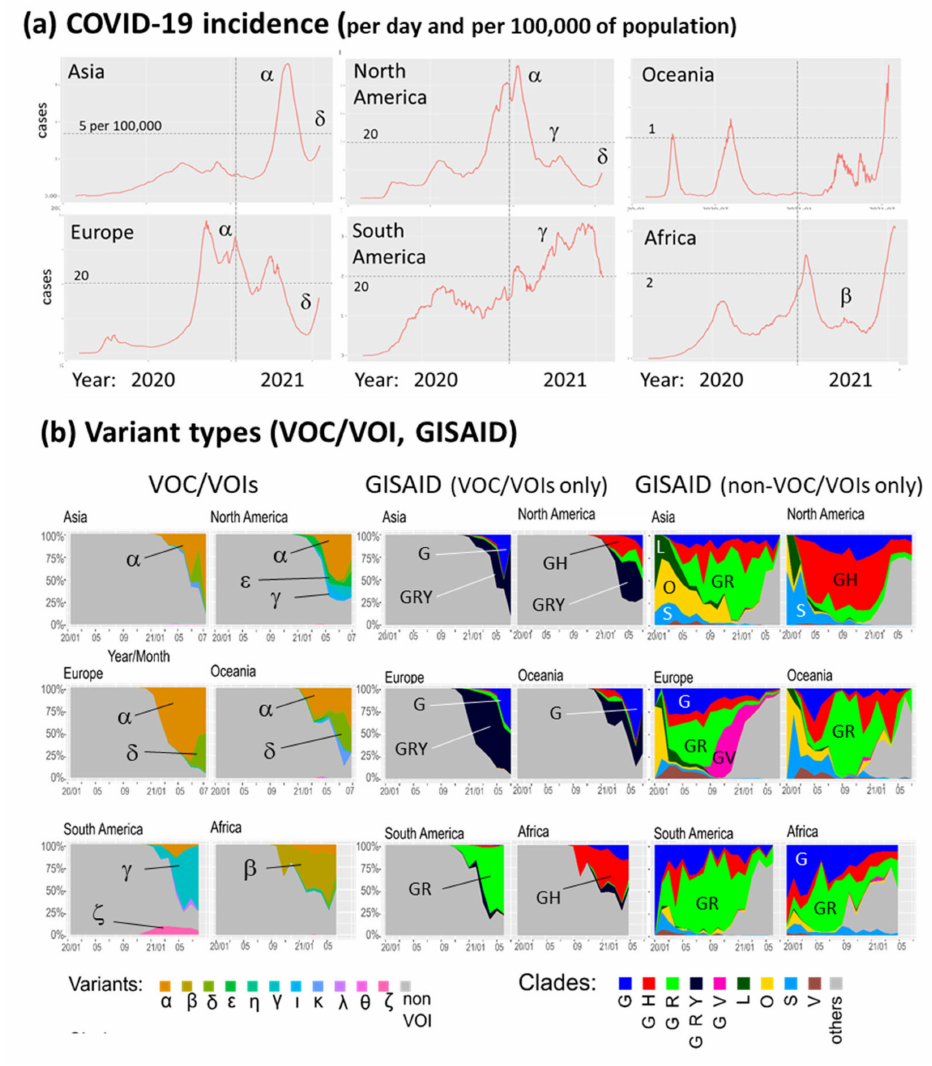
Figure 3. COVID-19 in time and space. ( a ) Incidence (in units of reported COVID-19 cases per day and per 100,000 of population) since January 2020 in different regions of the world. VOCs/VOIs (Greek letters) refer to the most abundant variants taken from part b. Plots were generated using the COVID-19 viewer (https://www.izbi.uni-leipzig.de/current-projects/covid19-viewer/, down- loaded at 17 July 2021) [28]. ( b ) Composition of COVID-19 cases regarding VOC/VOIs (left part) and GISAID (right part) grouping schemes. GISAID-clades were separately specified for VOC/VOI and non-VOC containing groups. SOM portraits of the different classes taken from the different regions were shown in Figure